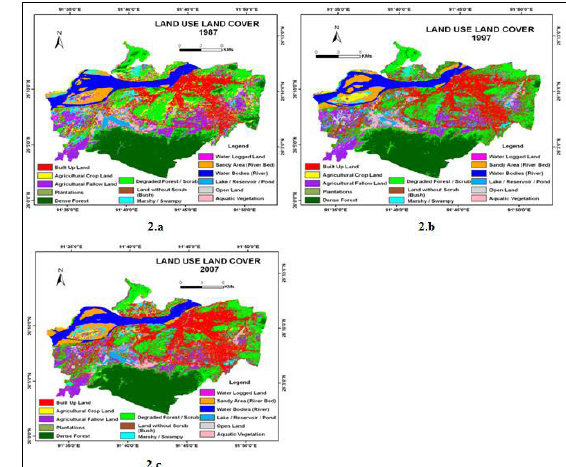
Figure 1. Location and satellite images of study area